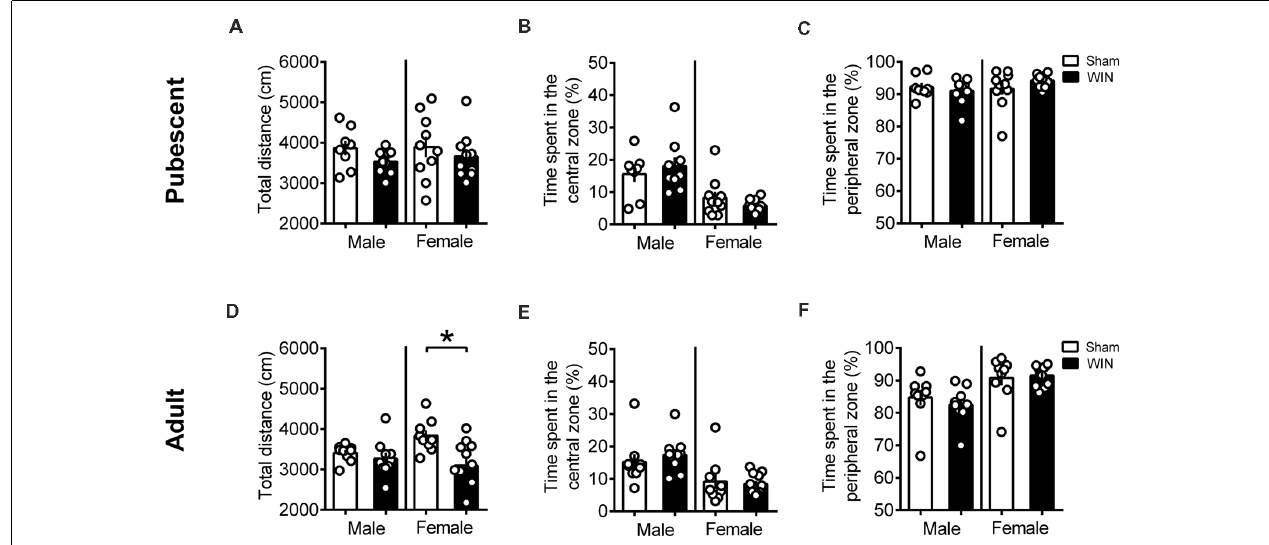
FIGURE 3 | Sex-specific effects in locomotion 24 h after single in vivo cannabinoid exposure. Single administration of WIN55,212-2 (WIN, 2 mg/kg, s.c.) 24 h before did not alter the distance traveled (A) nor the time spent in the central (B) or peripheral zone (C) of the apparatus in pubescent rats of both sexes during the open field test. At adulthood, WIN-exposed females had a reduction in the locomotion, while males were not affected (D) . Time spent in the central (E) or peripheral zone (F) remain unchanged in adult rats of both sexes. Data represent mean ± SEM. Scatter dot plot represents one animal. ∗ p < 0.05, Mann-Whitney U -test. Pubescent Males: Sham n = 8 and WIN n = 9; Pubescent Females: Sham = 10 and WIN = 10; Adult Males: Sham = 9 and WIN = 10; Adult Females: Sham n = 9 and WIN n = 11.